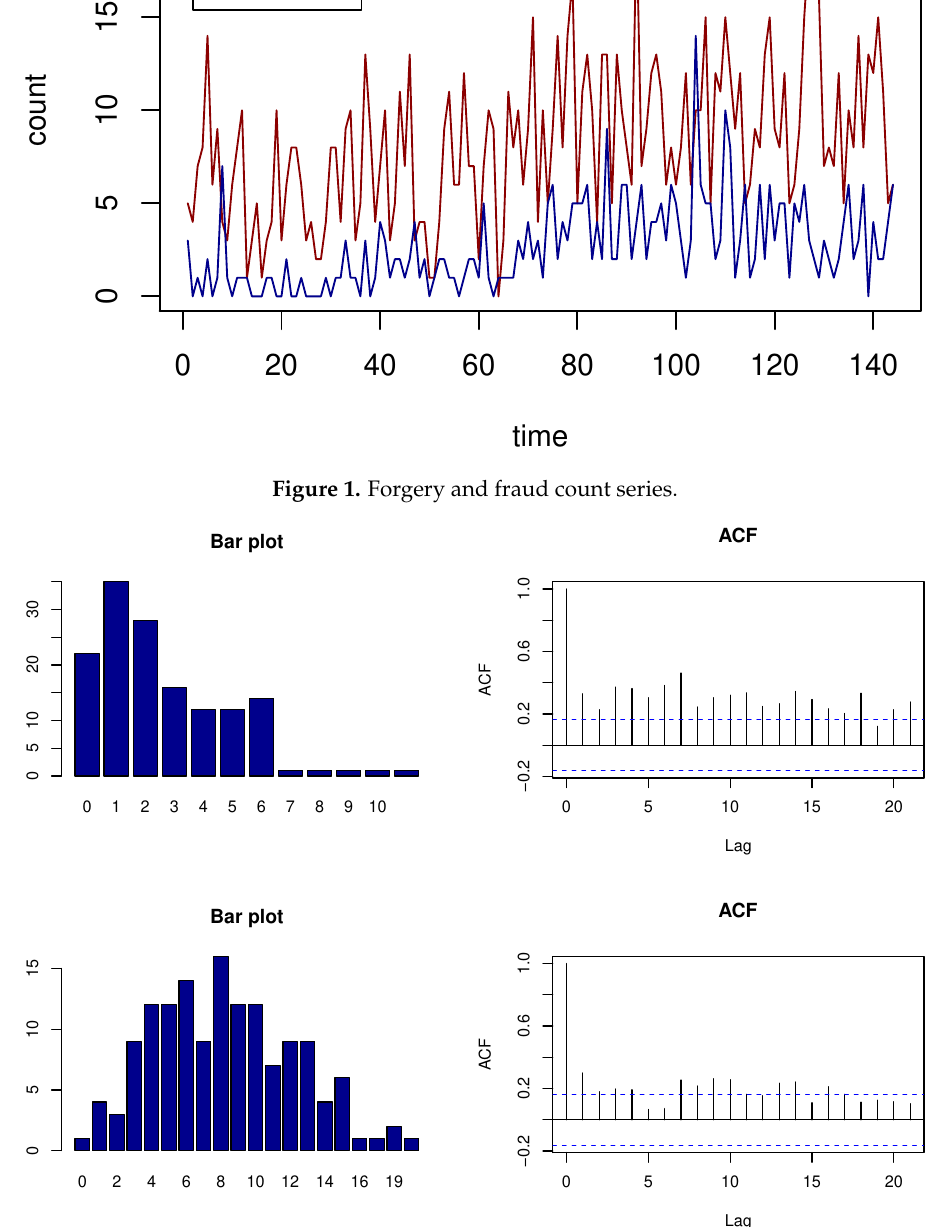
Figure 2. Bar plot and ACFs for counts of forgery ( top ) and fraud ( bottom ). Different copula families were fit for the univariate and joint distributions, and their corresponding AIC values are reported in Table 5. Parameter estimates and the correspond- ing standard deviations are recorded in Table